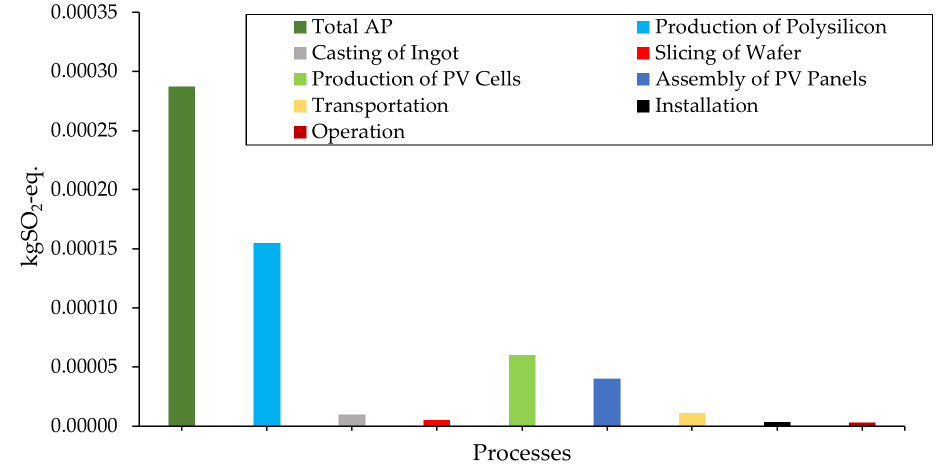
Figure 7. Acidification potential .